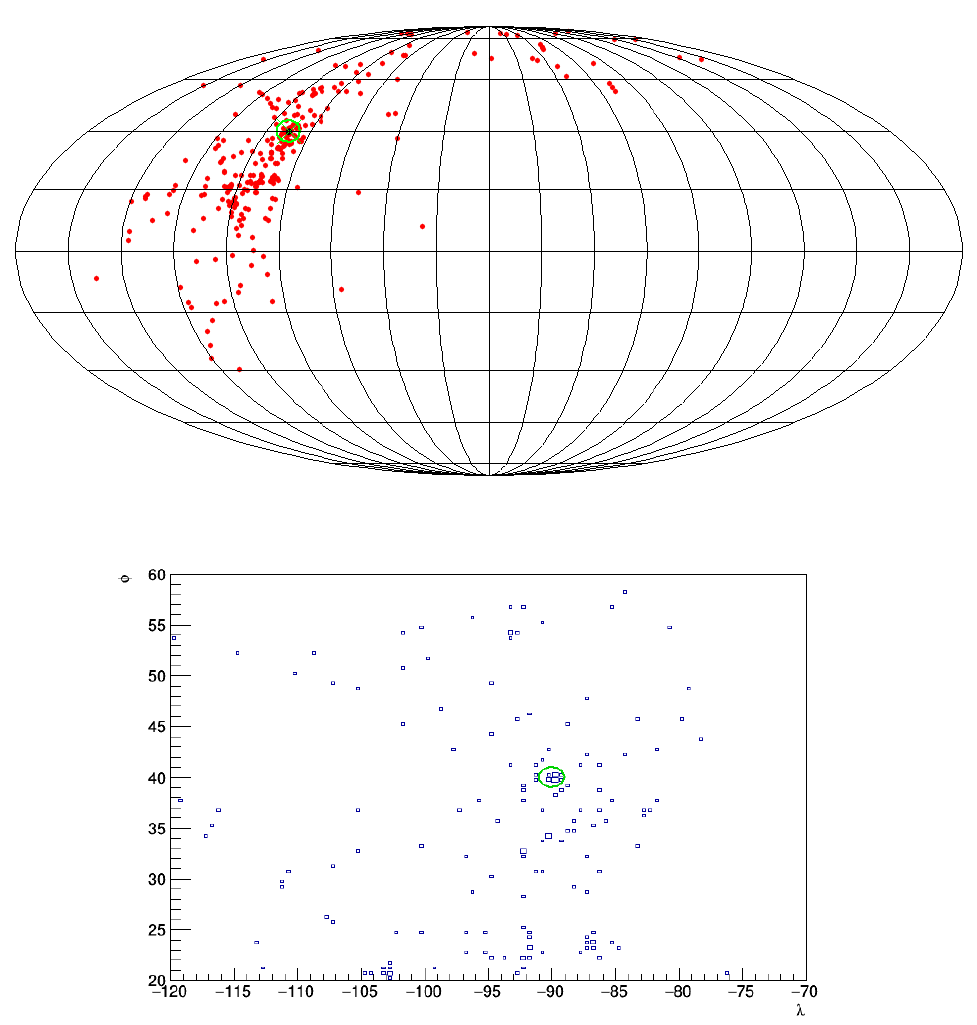
Figure 5. Estimation of possible directions of an incoming Cosmic-Ray Ensemble using the Time Based Triangulation method. Simulated signals from CRE were detected in 5 stations while in another 10 stations randomly generated background signals are present. In the upper plot all estimated directions in geographic coordinates system are shown in Mollweide projection. The correct CRE direction is denoted by the green circle, red points represent false estimates, obtained from calculations using at least one background signal. In the lower plot for selected range of latitude, φ , and longitude, λ , the calculated directions are shown as boxes, the correct ones are in the green